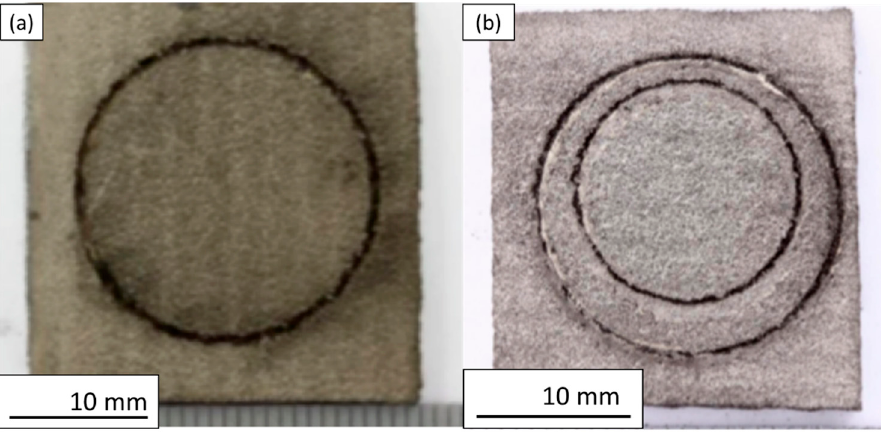
Figure 10. Wear scars from pin-on-disc testing of ( a ) nickel and ( b ) Ni + NCG 13.3 vol% graphite coating.